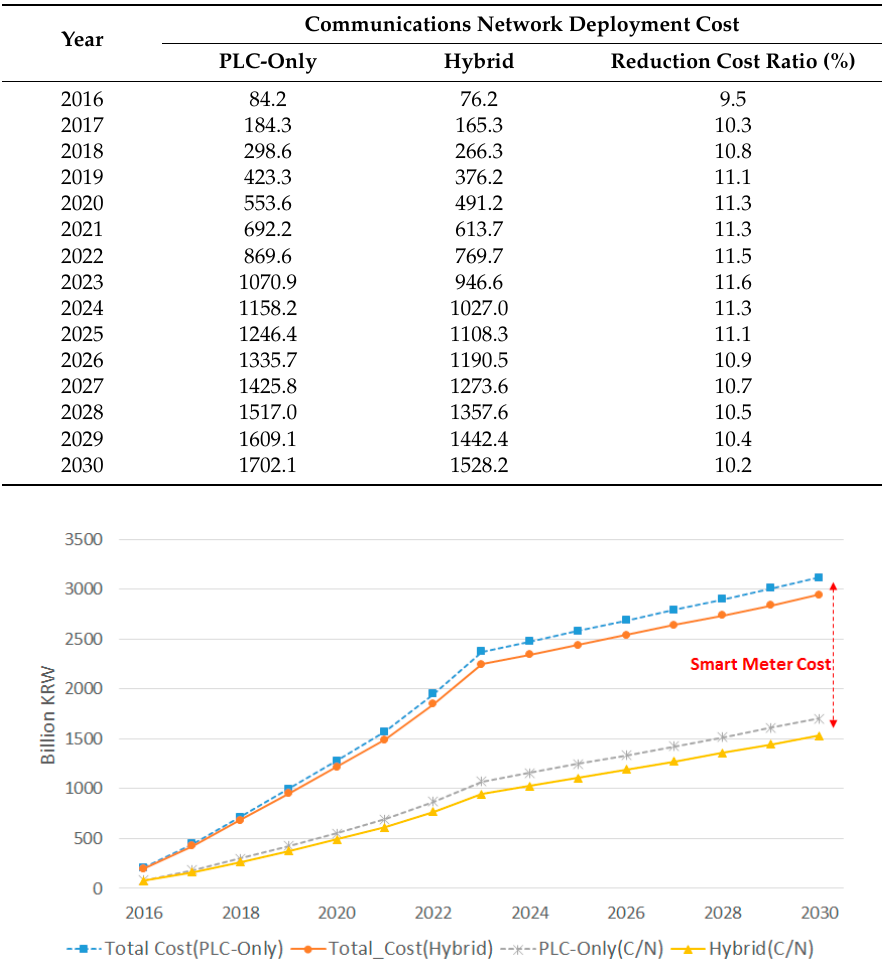
Table 4. Communications Network Cost per Deployment Type (Billion KRW).